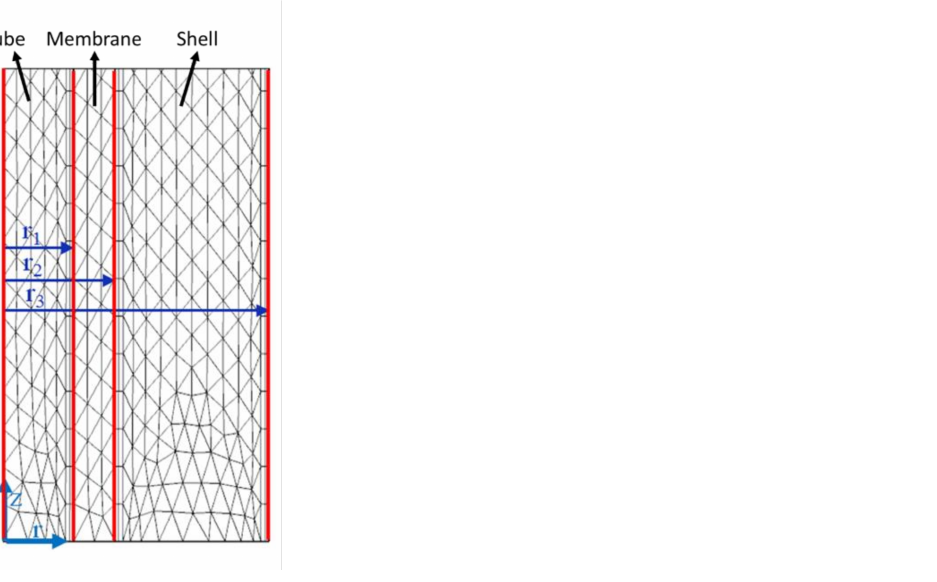
Figure 3. Schematic of a segment of the half longitudinal section of a single fiber mesh